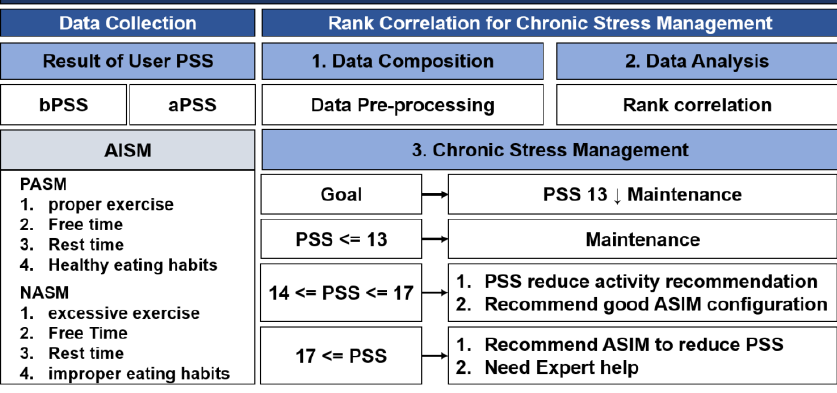
Figure 5. Activity recommendation model using rank correlation for chronic stress management.